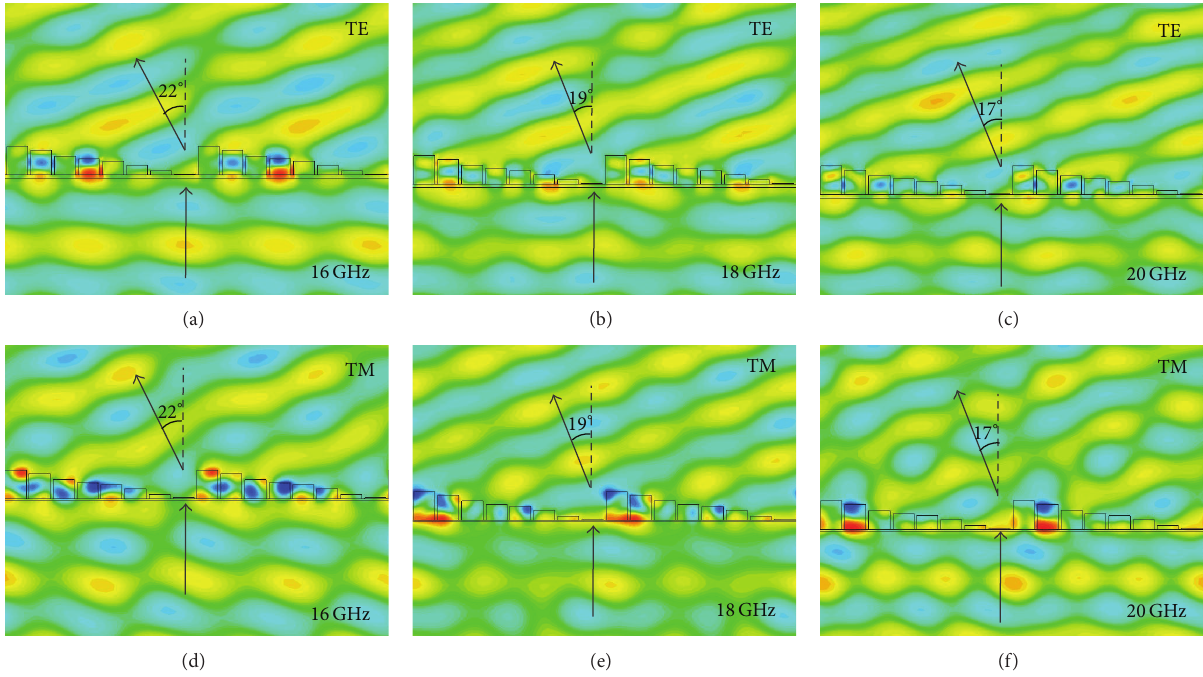
Figure 3: Time snapshots of the simulated steady-state electric field when plane waves are normally impinging on the nonuniform dielectric metasurface from the bottom. TE polarization incident waves (a) at 16GHz, (b) at 18 GHz, and (c) at 20GHz. TM polarization incident waves (d) at 16GHz, (e) at 18GHz, and (f) at